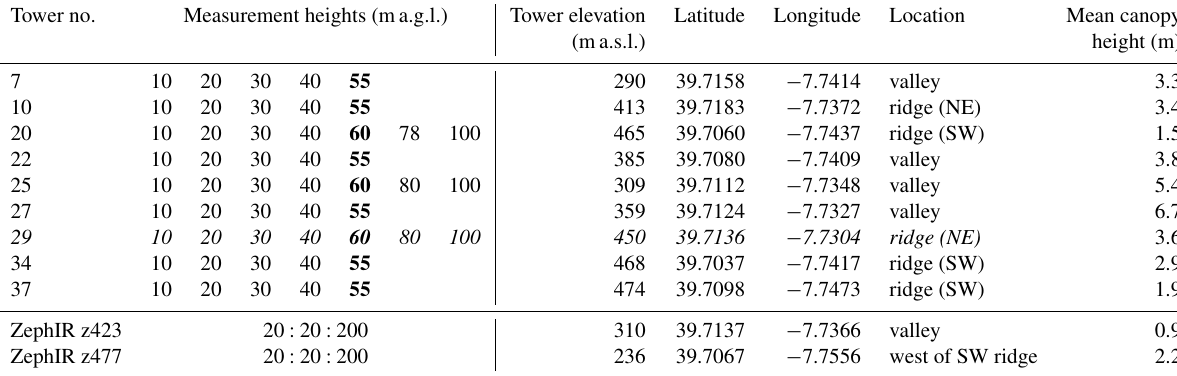
Table 1. Locations and measurement heights of each meteorological mast (tower) and each ZephIR lidar. Measurement heights referred to in this paper as “60m” are shown in bold. Reference tower (Tower 29) is emphasized by italics. Tower base elevations are given in meters above sea level (a.s.l.) and mean vegetation height is calculated from aerial laser scans in a 50m square cell surrounding each tower or ZephIR lidar. Definitions used to conditionally sample the towers as valley or ridge are also shown along with a parenthetical statement of their location on the northeast (NE) or southwest (SW) ridge. Valley towers are those with elevations below 400ma.s.l. Tower